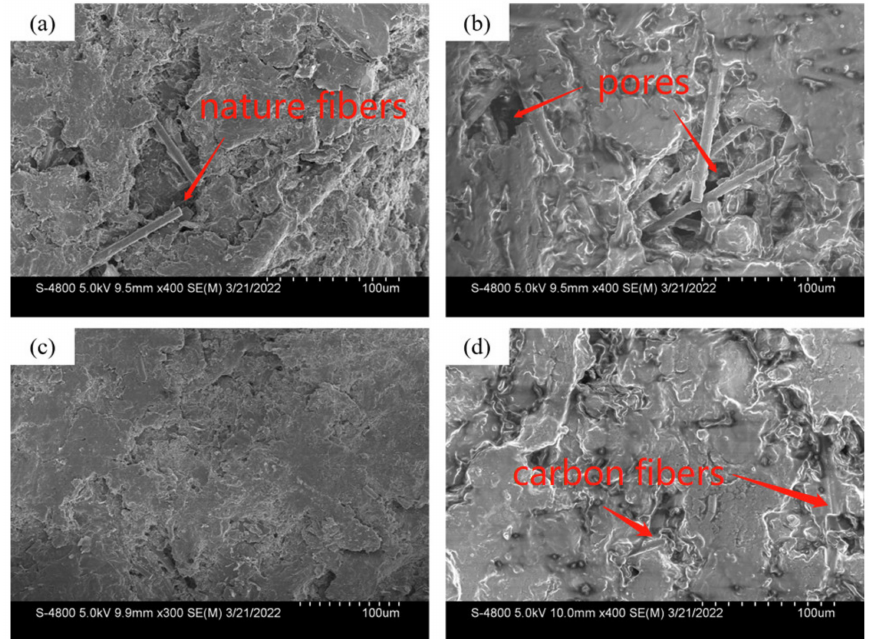
Figure 14. Topography of initial surfaces A ( a ) and B ( c ), and tested surfaces A ( b ) and B ( d ).